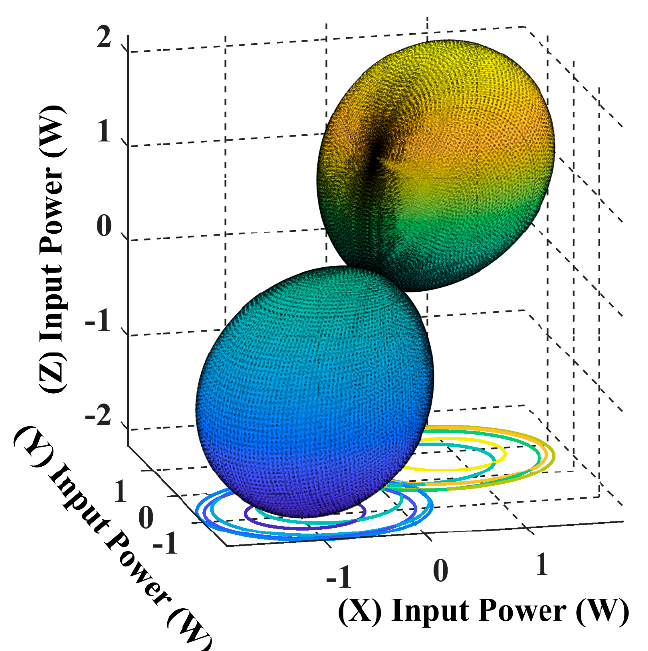
Figure 11. The input power spherical plot for the 3D WPT system when the receiver is placed at α = φ = 45°.